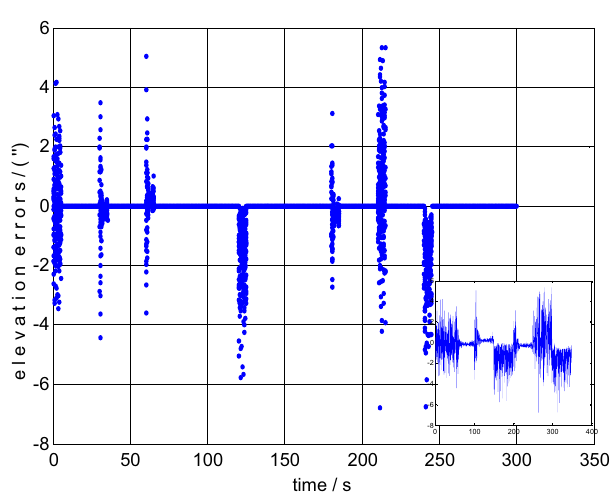
Figure 7. The dynamic elevation errors of group 1.